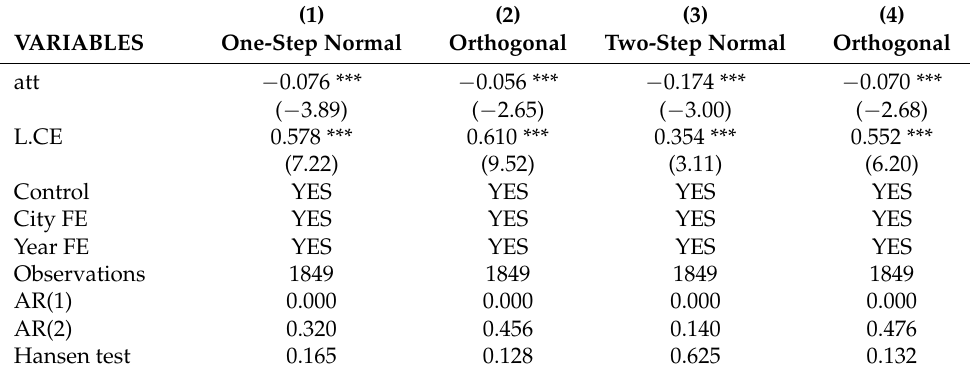
Table 5. Estimation results of the system GMM for